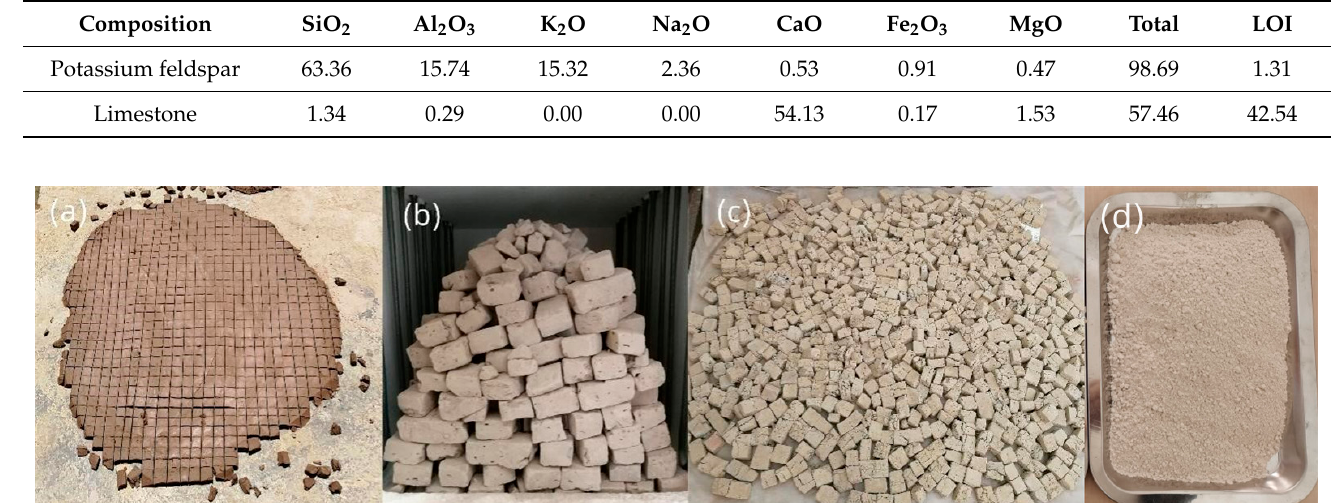
Figure 1. HL preparation: ( a ) Potassium feldspar and limestone mixed with water; ( b ) after calcination; ( c ) sample slaking; ( d ) powder.